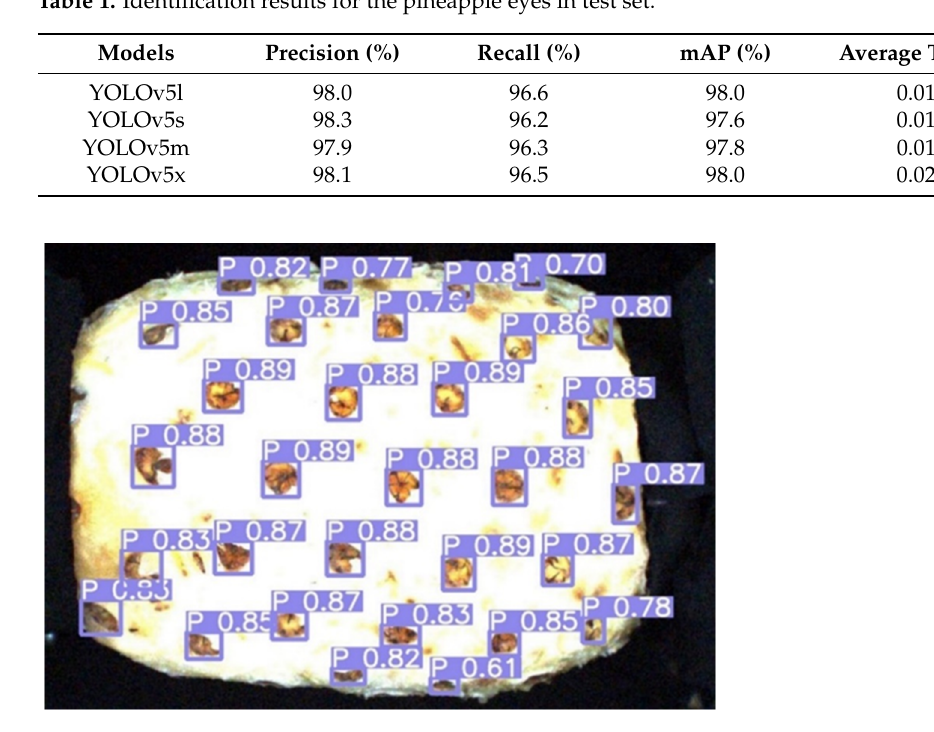
Figure 13. P–R curve.